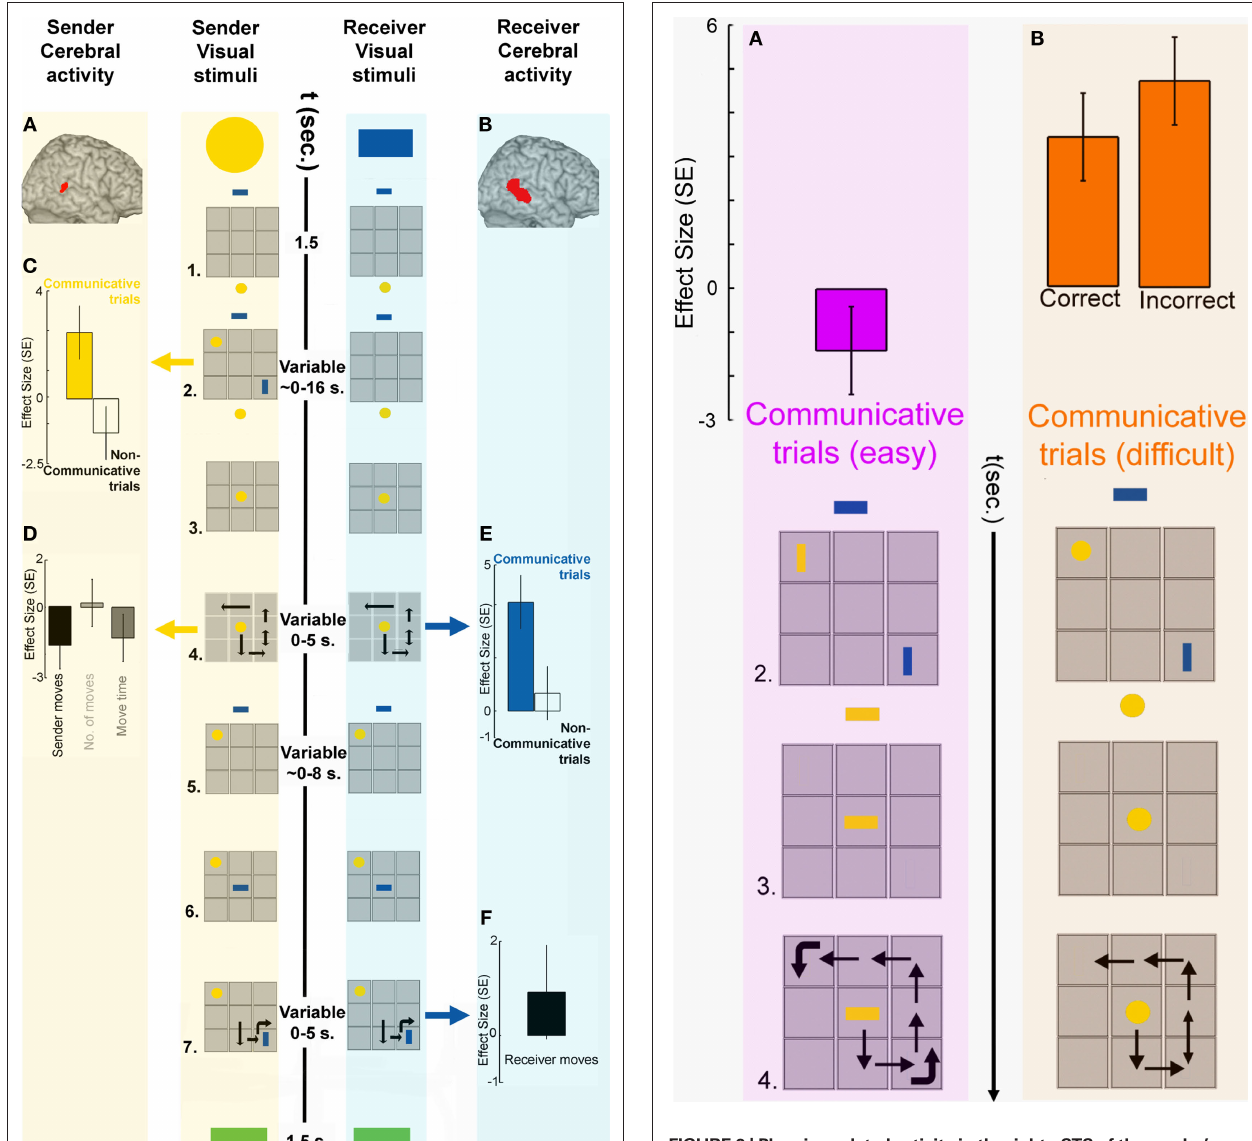
FIGURE 3 | Planning-related activity in the right pSTS of the sender’s brain was modulated by the diffi culty of selecting an adequate communicative behaviour. (A) When the sender could indicate the goal position of the receiver’s token (blue rectangle) by aligning his token (yellow rectangle) with her goal position, there was no signifi cant right pSTS activity (in magenta). (B) When the sender could not match the goal orientation of the receiver’s token (blue rectangle) with his token (yellow circle), there was robust right pSTS activity (in orange), both for correct and incorrect trials. Other conventions as in Figures 1 and 2